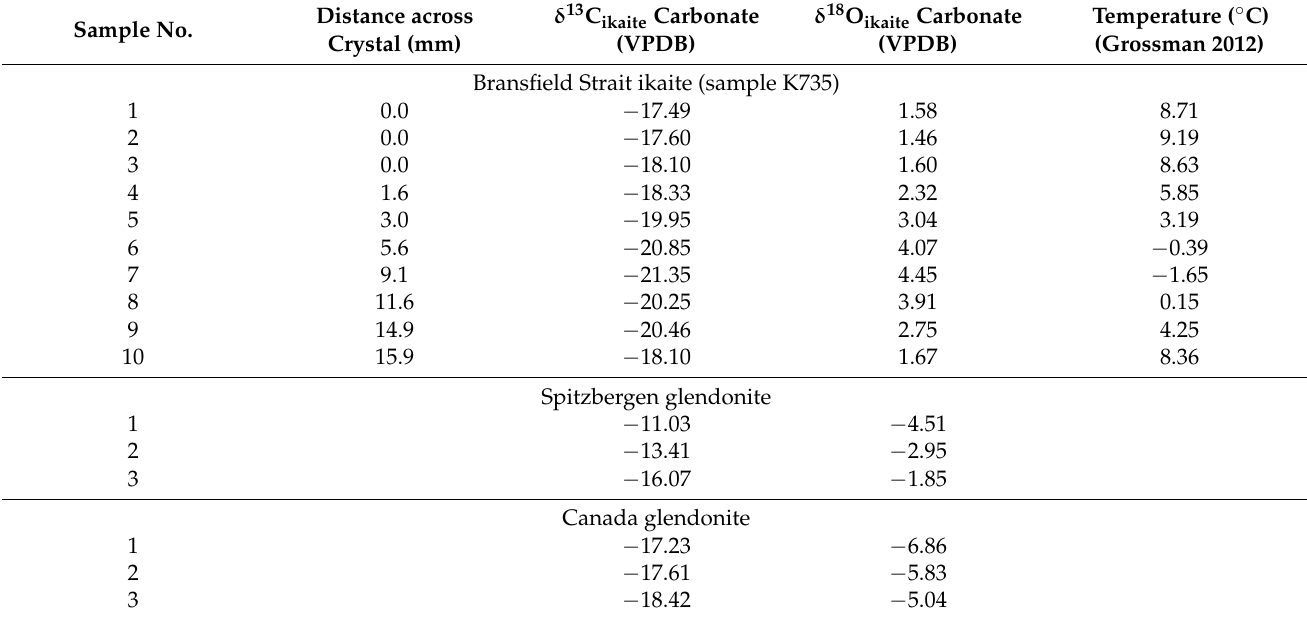
Table 2. Carbon and oxygen profiles across ikaite crystal (sample K735) and glendonites. Sample